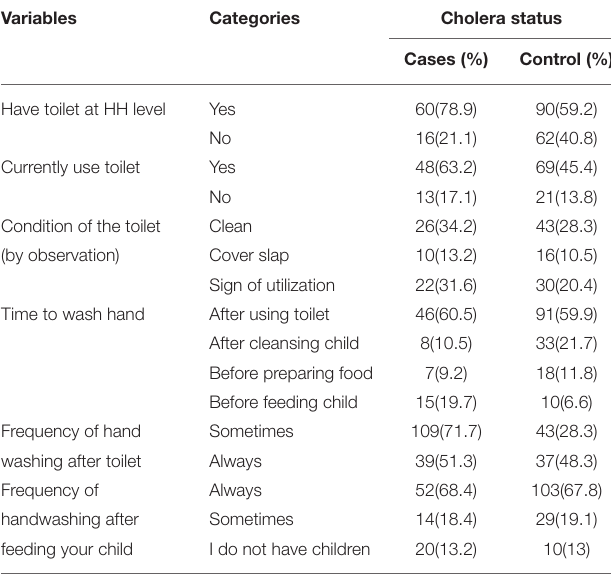
TABLE 3 | Hygiene and sanitation characteristics in Erer District, 2019.